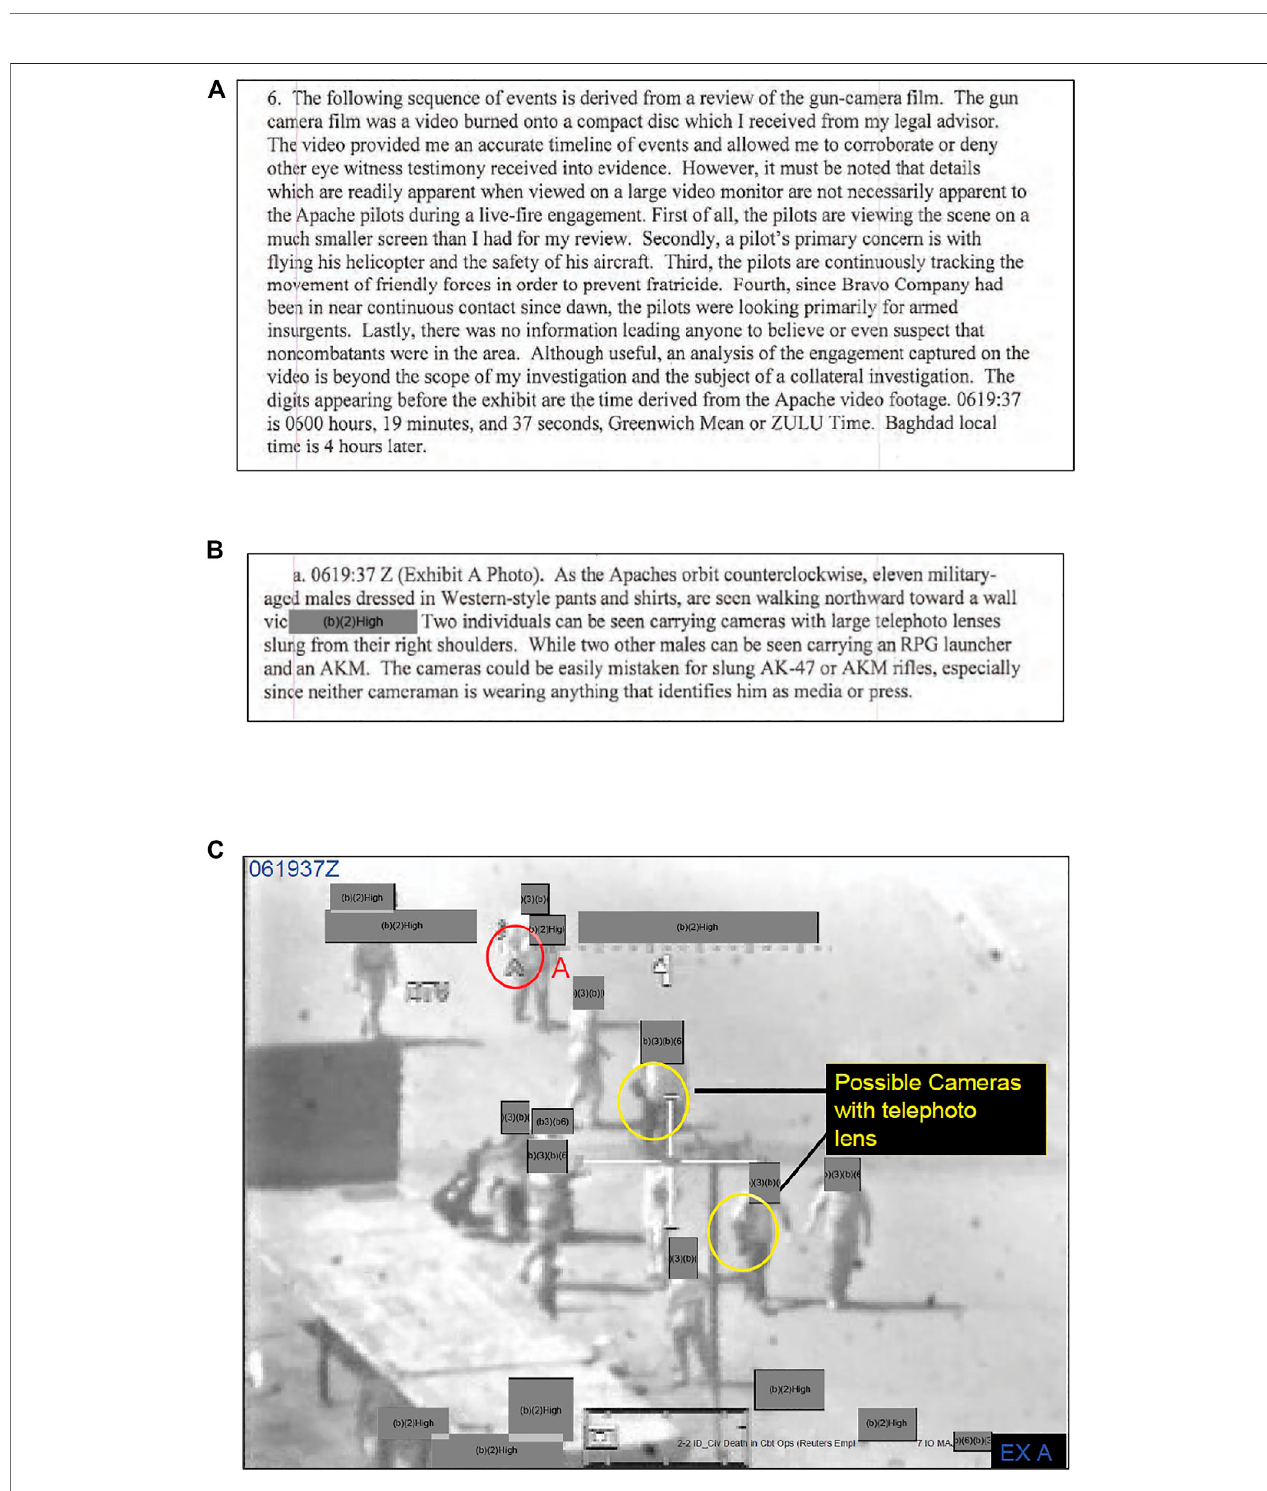
FIGURE 4 | (A) and (B) Paired extracts from the US military AR 15-16 investigation (Iraq, July 12, 2007). (C) Exhibit A Photo ’ from the US military AR 15-16 investigation (Iraq, 12 July 2007).